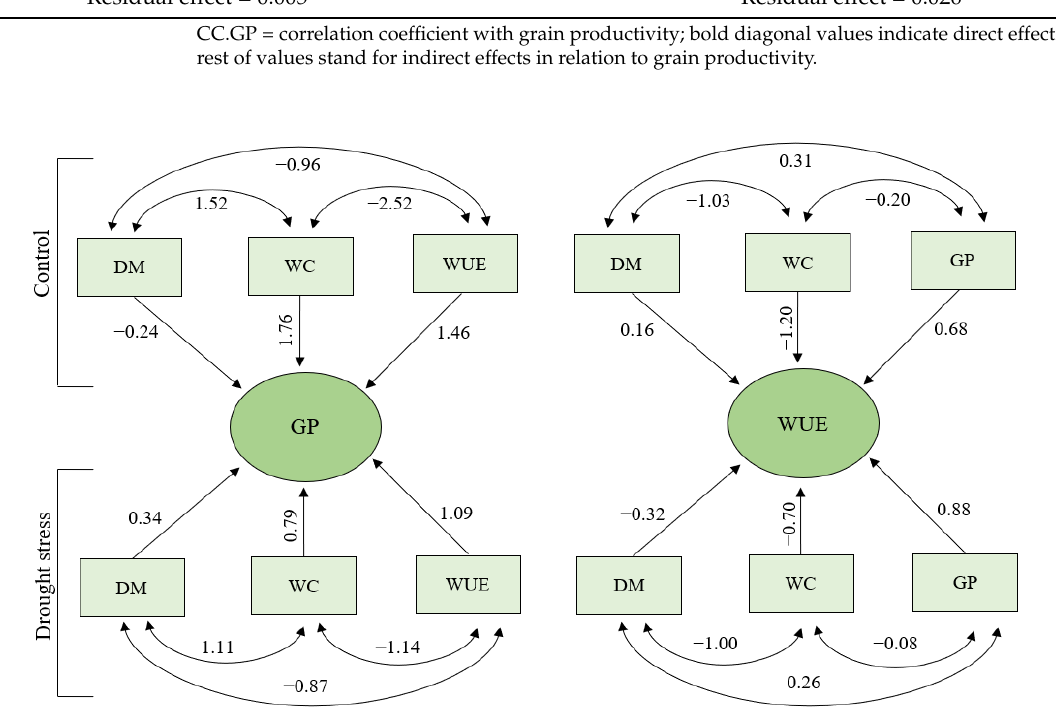
Figure 5. Path diagram indicating total direct and indirect effects of computed attributes on the grain productivity (GP: left) and water use efficiency (WUE: right) from control and drought stress treatments. DM: days to maturity, WC: water consumption, WUE: water use efficiency. Table 4. Path analysis for the direct and indirect effects of studied traits including days to maturity (DM), water consumption (WC) and water use efficiency (WUE) on the grain productivity (GP) of lowland rice cultivars under control and drought stress treatments.